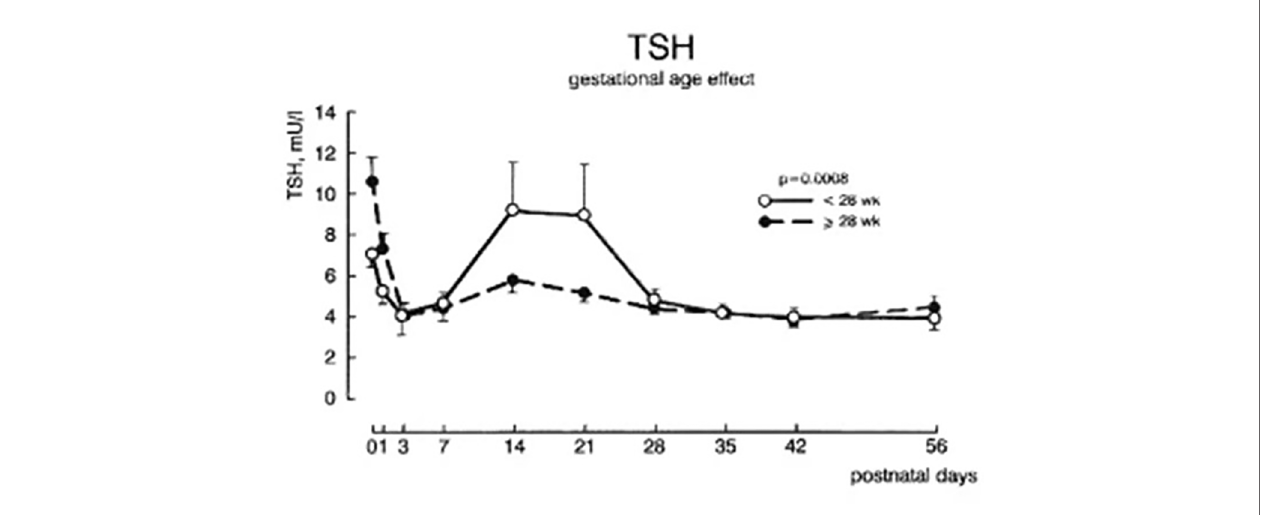
FIGURE 4 | Plasma TSH concentrations ± SEM during the fi rst 8 weeks after birth in infants of 28-30 week gestation and <28 weeks gestation. With permission from van Wassenaer AG, Kok JH, Dekker FW de Vijlder JJ. Thyroid function in very preterm infants: in fl uences of gestational age and disease. Pediatr Res 1997; 42:604-9